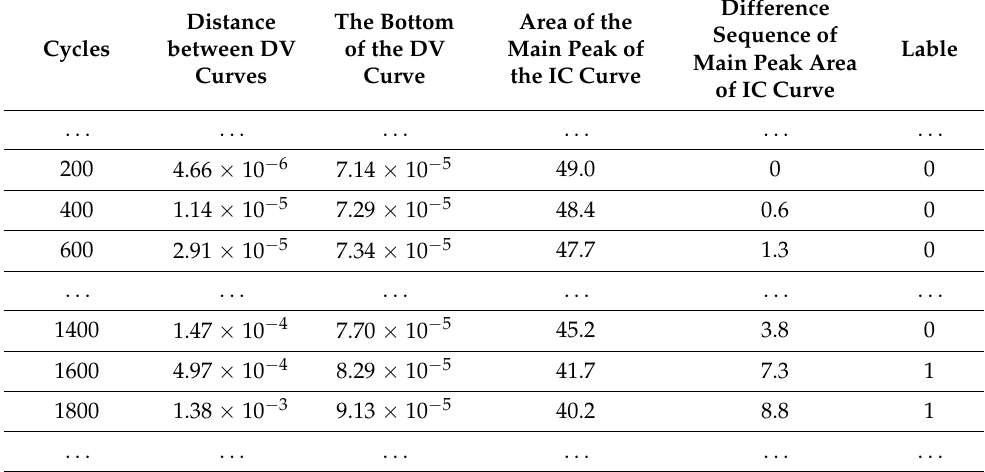
Table 3. Model verification results of a battery of the same type. Distance Cycles